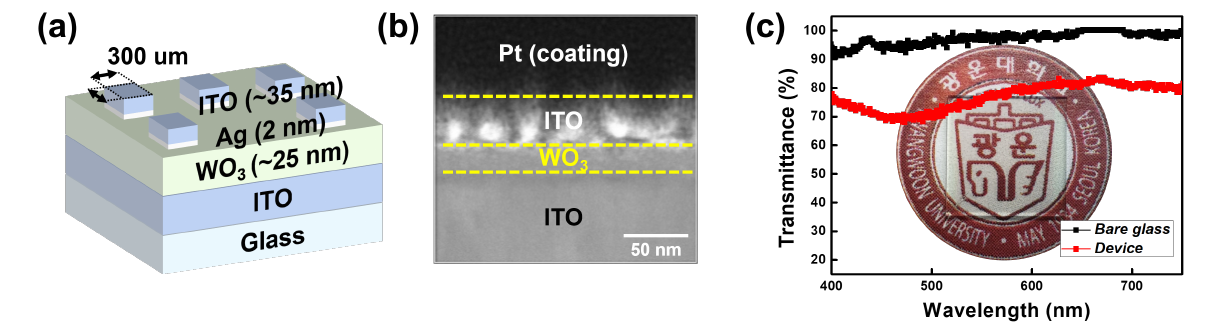
Figure 1. ( a ) Simple illustration of the developed Ag-based transparent threshold switch. ( b ) Cross- sectional TEM image of the developed device. ( c ) Optical transmittance of the device with photo image.